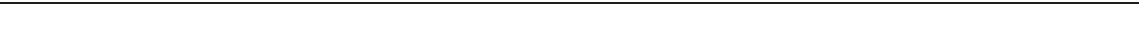
Fig. 5 Nfkbid regulation by Roquin redundantly involves decapping and deadenylation. a Schematic representation of ICOS reporter constructs with or without 5 ′ cap (m 7 G) and poly(A) tail (polyA). ( b ) Flow cytometry analysis of ICOS reporter expression in Rc3h1 – 2 − / − MEF cells containing a